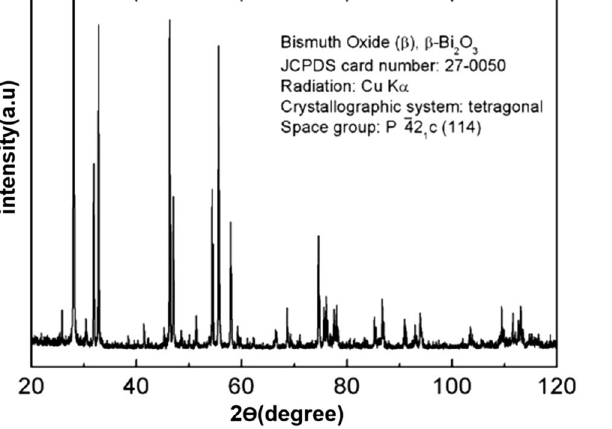
Figure 4. Reference XRD spectra of Bi 2 O 3